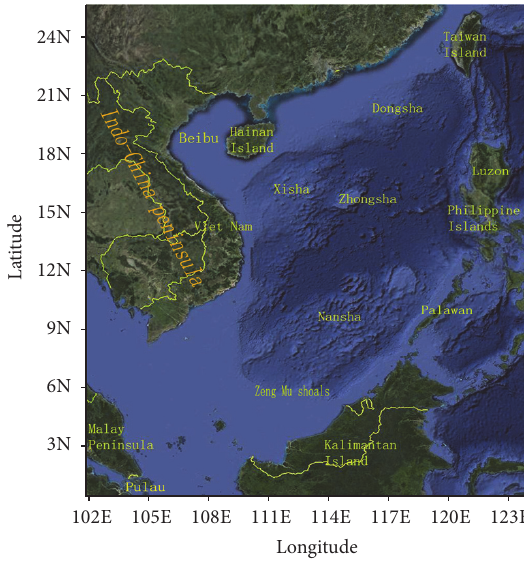
Figure 1: Geography of the South China Sea.